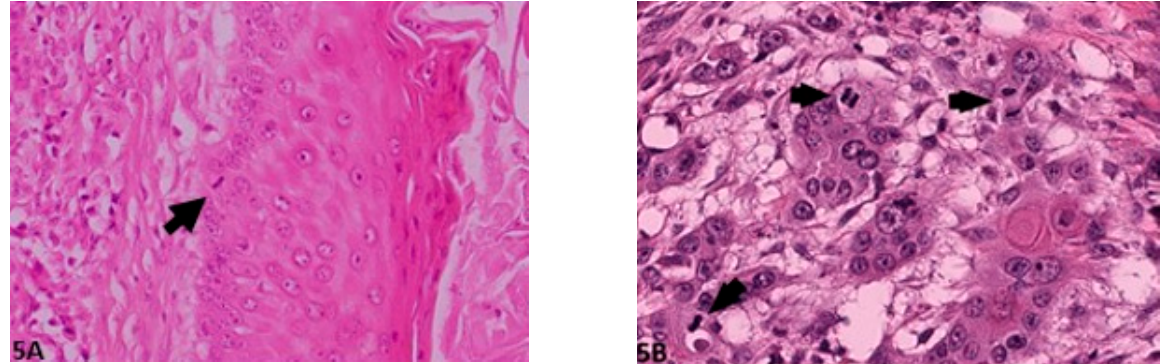
Figure 5. Mitosis per HPF: ( A ) (O.M. 40×): Single mitotic figure (arrow, Gordon Setter, No. 50); ( B ) (O.M. 40 x): Multiple mitotic figures (arrows, Gordon Setter, No. 56). O.M: original magnification.